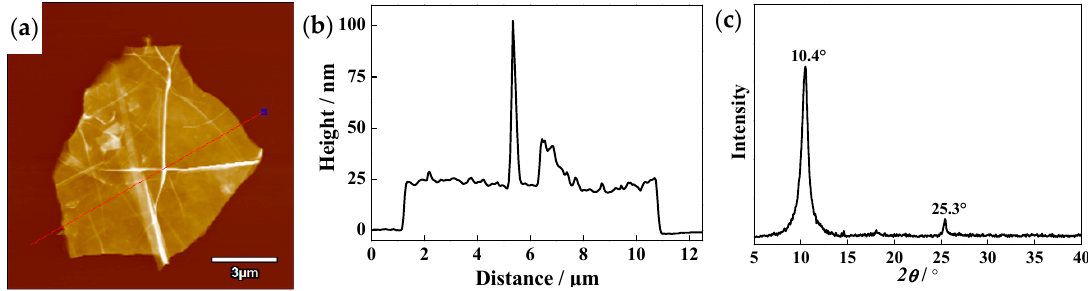
Figure 3. Atomic force microscopy (AFM) image and XRD pattern of GO after ultrasonic dispersing ( a ) top-view image; ( b ) corresponding cross-section height analysis; ( c ) XRD pattern.